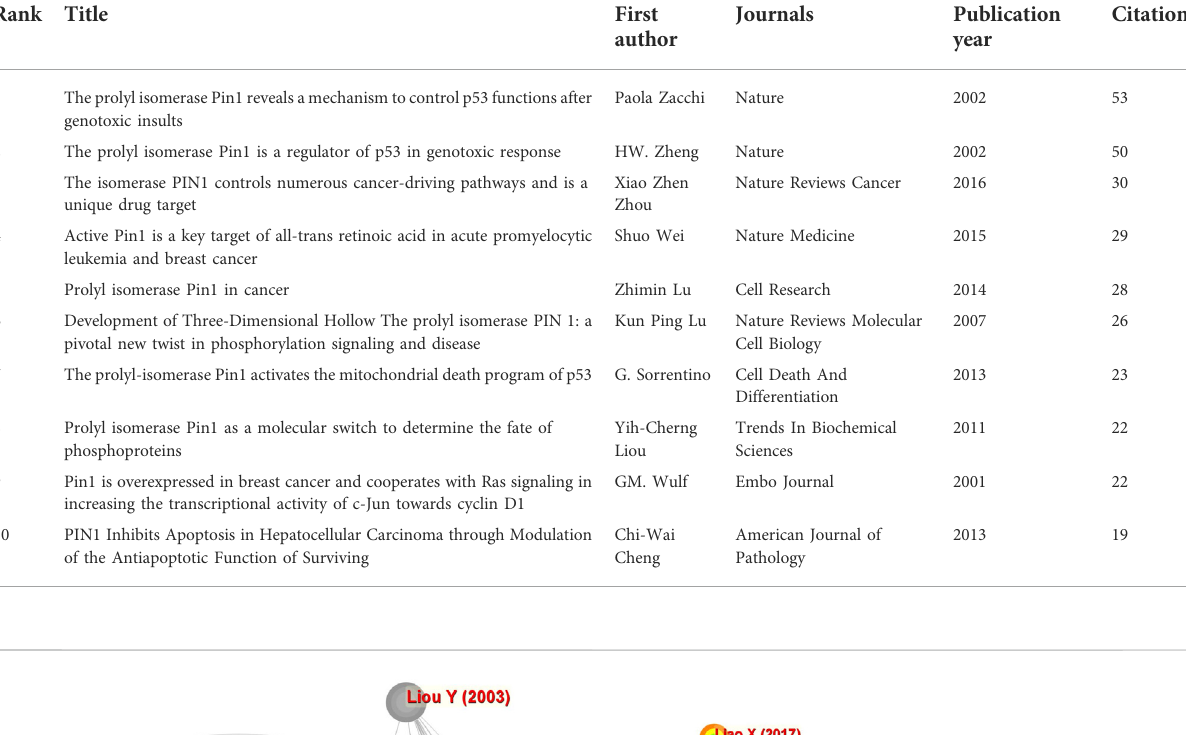
TABLE 6 Top 10 highly co-cited documents.